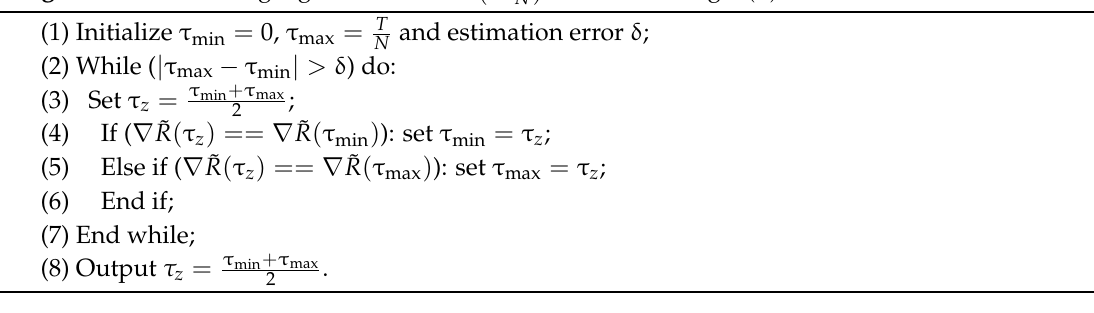
Algorithm 1: Searching algorithm of τ z ∈